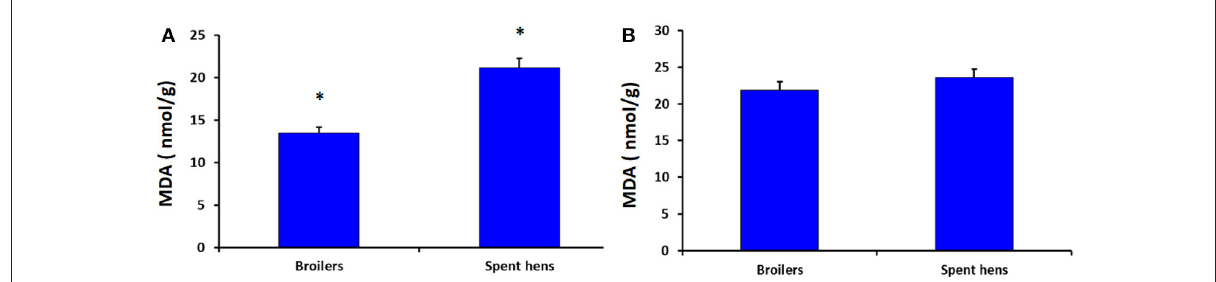
FIGURE1 The concentrations of malondialdehyde (MDA) in the breast (A) and thigh (B) muscles ( P = 0.001 and 0.328, respectively) of broiler chickens and spent laying hens. * Significant at level P <